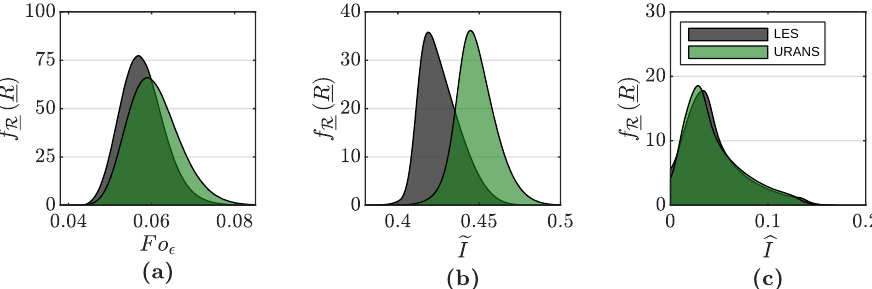
Figure 16. Probability density functions for the random responses: ( a ) mixing time Fo (cid:101) , ( b ) integral mean segregation intensity (cid:101) I , and ( c ) mean absolute deviation to the reference case of the segregation intensity (cid:98) I